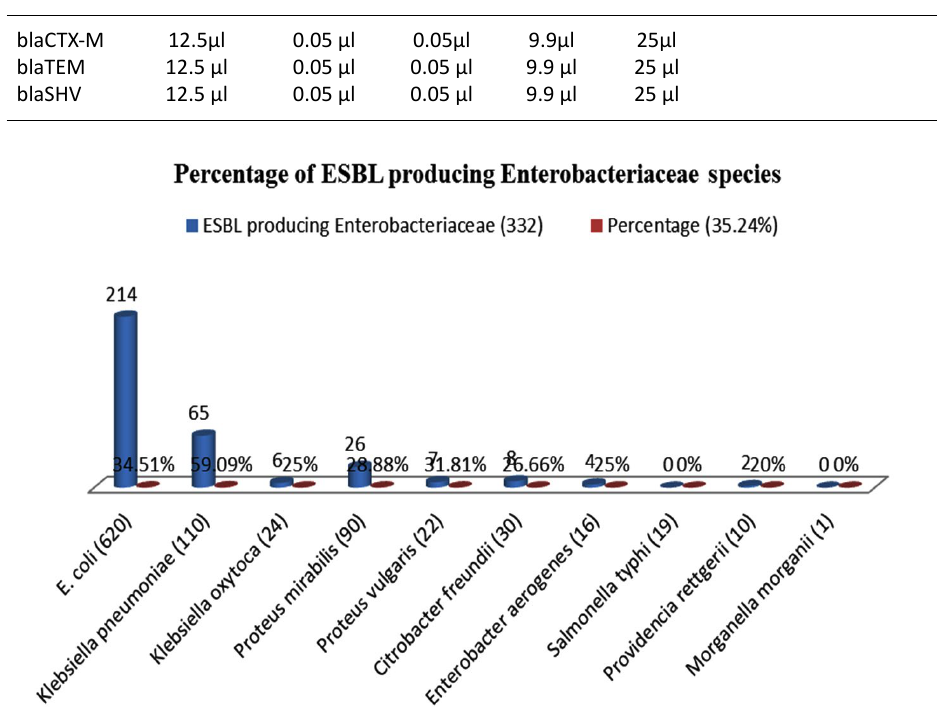
Fig. 1. Percentage of ESBL producing Enterobacteriaceae